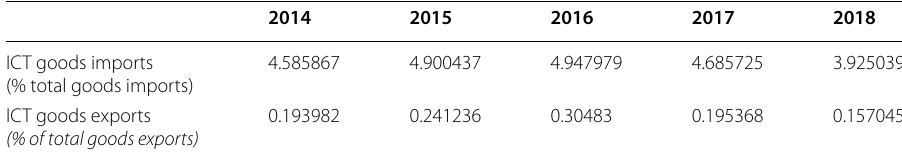
Table 1 Imports and exports of ICT goods in Pakistan (World Bank, n.d.)